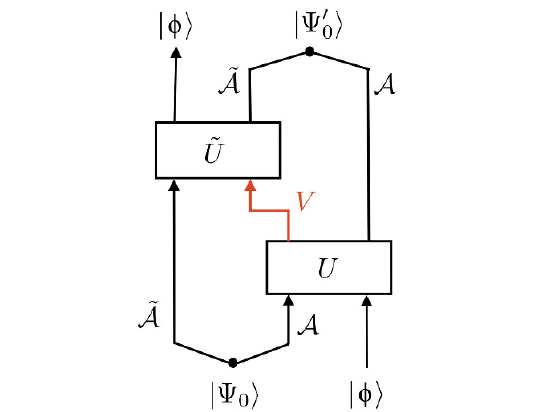
Figure 18 . An analogue of the Hayden-Preskill protocol: the code subspace approximately factor- izes into a tensor product corresponding to the algebras A , e A . These tensor factors are entangled and provide the reservoir of EPR pairs needed to perform the teleportation. Here U; e U is time evolution in the CFT and V (cid:25) O e O denotes the perturbation of the CFT Hamiltonian. The (cid:12)gure describes the part of the information (cid:13)ow that is relevant for reconstructing an infalling state j (cid:30) i through measurements behind the horizon. A mirrored diagram exists for the opposite process in which a state is sent from the inside to the